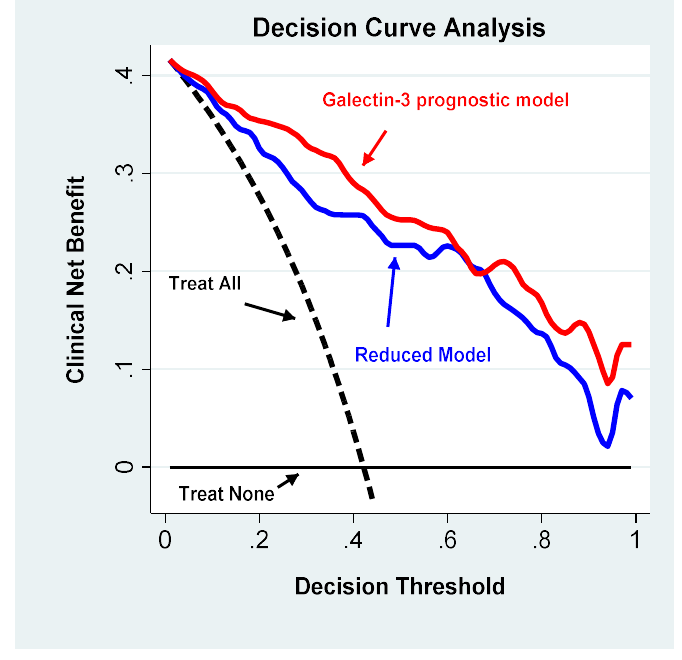
Figure 2. Decision Curve Analysis. The “treat none” (black continuous line) and “treat all’ (black continuous line) curves are compared with the net benefit curves of the two multivariate models: Galectin-3 prognostic model (red continuous line) and partial model without Galectin-3 (blue continuous line). The full model profile is higher than the partial model profile across the critical range of the decision threshold probabilities (20–60%). Both models show curves above those of the “treat none” and “treat all” strategies.